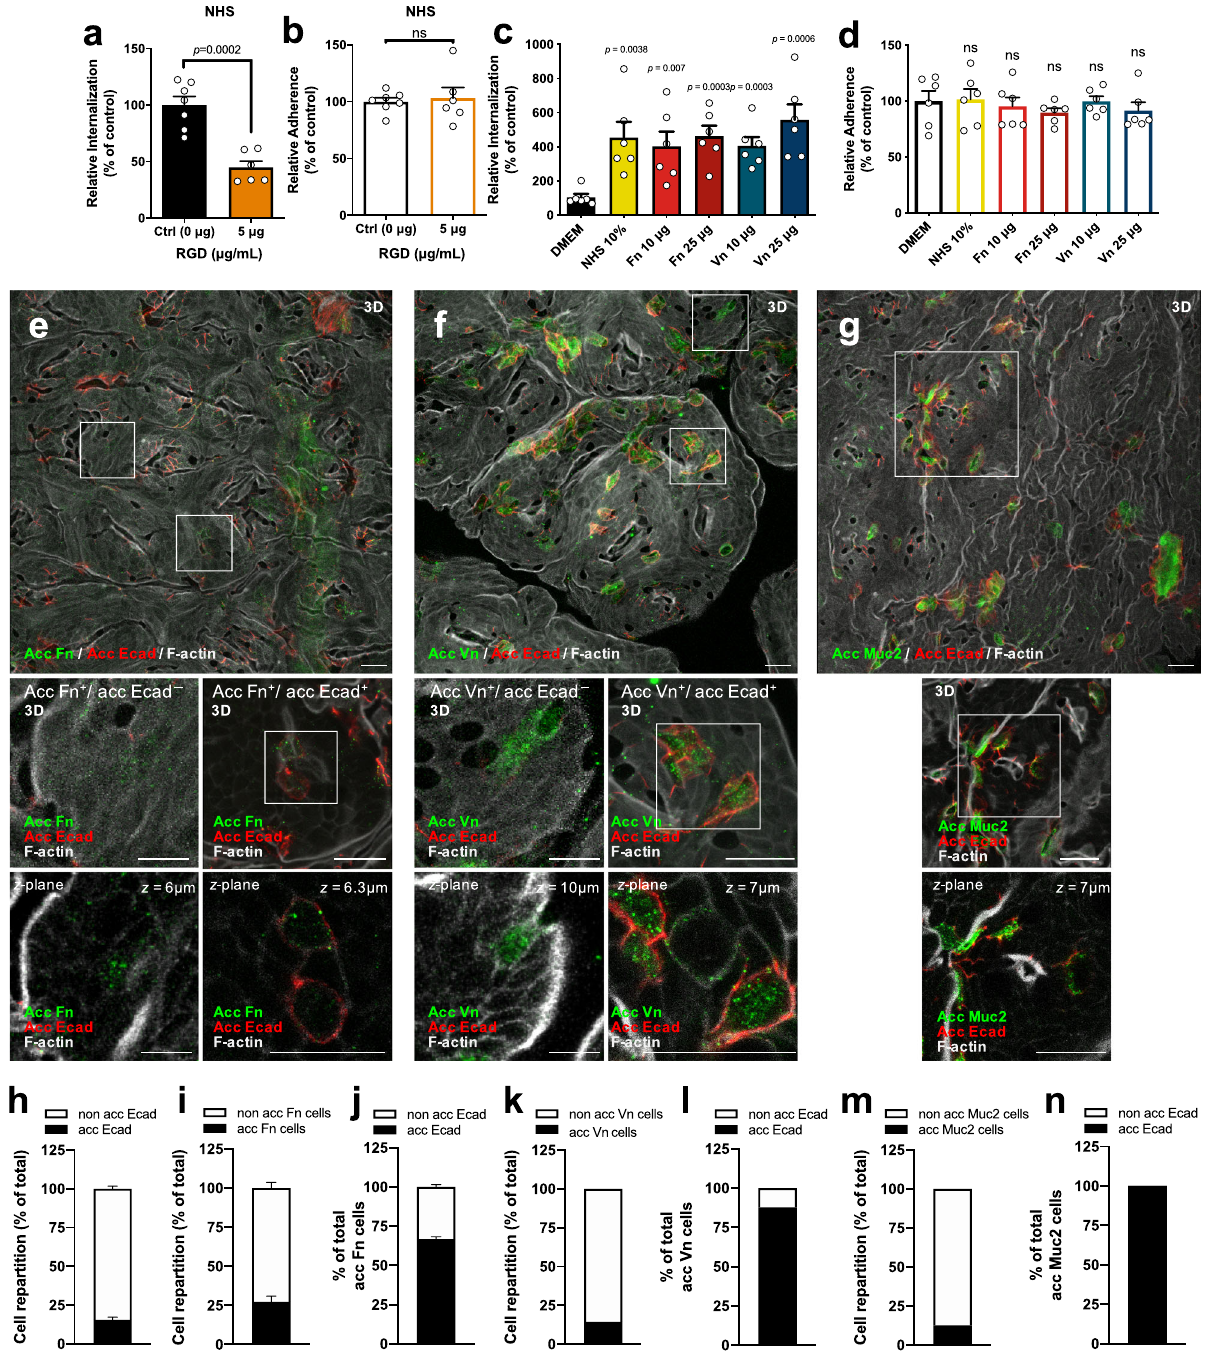
Fig. 3 C. dif fi cile spore internalization requires Fn and Vn which are luminally accessible in the intestinal barrier. a Internalization b and adherence of C. dif fi cile spores preincubated with NHS in differentiated monolayers of Caco-2 in the presence of RGD peptide. c , d Differentiated Caco-2 cells were infected with C. dif fi cile spores preincubated with DMEM, NHS, Fn, or Vn. Data shown in each panel are normalized to the control. In bars, each dot represents one independent well from a to d three independent experiments. e – g Representative confocal micrographs of fi xed whole-mount of the healthy colon of n = 2 mice for e accessible Fn (acc Fn); f accessible Vn (acc Vn); and g accessible Muc2 (acc Muc2) with accessible Ecad (acc Ecad). The main fi gure shown a 3D projection, below magni fi cations, and a z -stack of representative cells with different immunostaining. The fi gures h – n shows the cell repartition of cell immunodetected for h acc Ecad, i acc Fn, j total acc Fn cells that were immunodetected for acc Ecad, k cells immunodetected for acc Vn, l total acc Vn cells that were immunodetected for acc Ecad, m acc Muc2, n total acc Muc2 cells that were immunodetected for acc Ecad. h – n 1000 – 1200 cells were counted per fi eld in two independent mice. h Four fi elds per mice, n = 2 mice; i , j two fi elds per mice, n = 2 mice; k , l one fi eld per mice, n = 2 mice. Acc Fn, acc Vn, and Muc2 are shown in green, acc Ecad is shown in red, and F-actin in gray ( fl uorophores colors were digitally reassigned for a better representation). Scale bar, 20 µ m. Error bars indicate mean ± S.E.M. Statistical analysis was performed by two-tailed unpaired Student ’ s t test, ns, p > 0.05; **** p < 0.0001. Scale bar, 20 µ m.